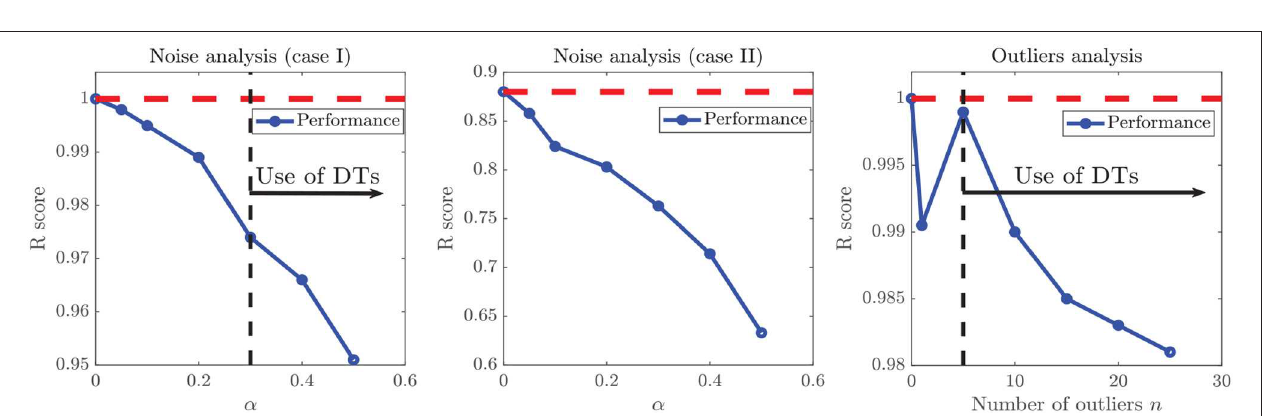
FIGURE 7 | Model-prediction of the simulated linear dataset with α − induced noise in 100 data points. The plots represent predicted (y) vs. real (ground truth without noise, x) data points (circles), the identity line (continuous line), and the crude linear statistical regression of the scatter (discontinuous line). Since training datasets for models included noise, we expect particular discordance between the dispersion of high α scenarios and the predictive outcome of noise-fitting models trained therein, when compared to the original noise-free dataset.